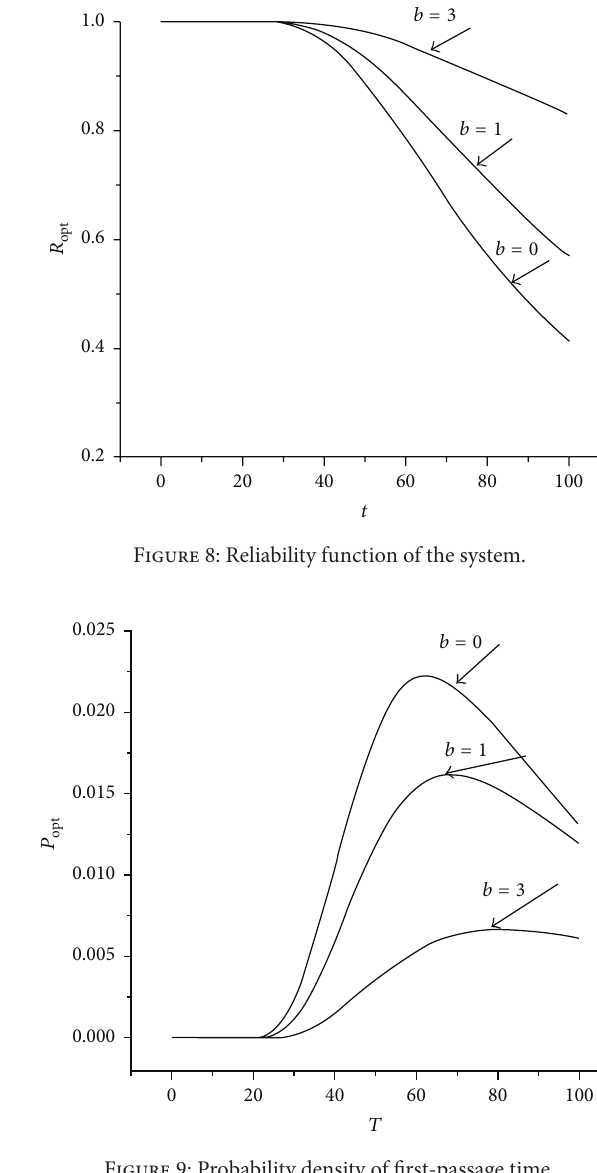
Figure 9: Probability density of first-passage